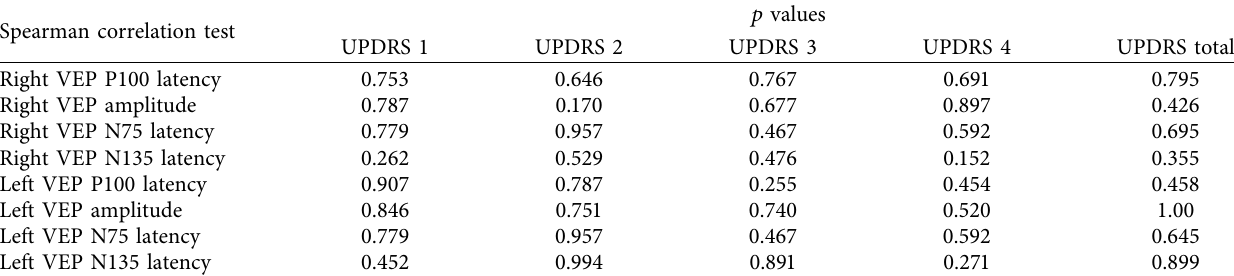
Table 6: p -values for the correlation between VEP variables and UPDRS score in the PD group. Spearman correlation